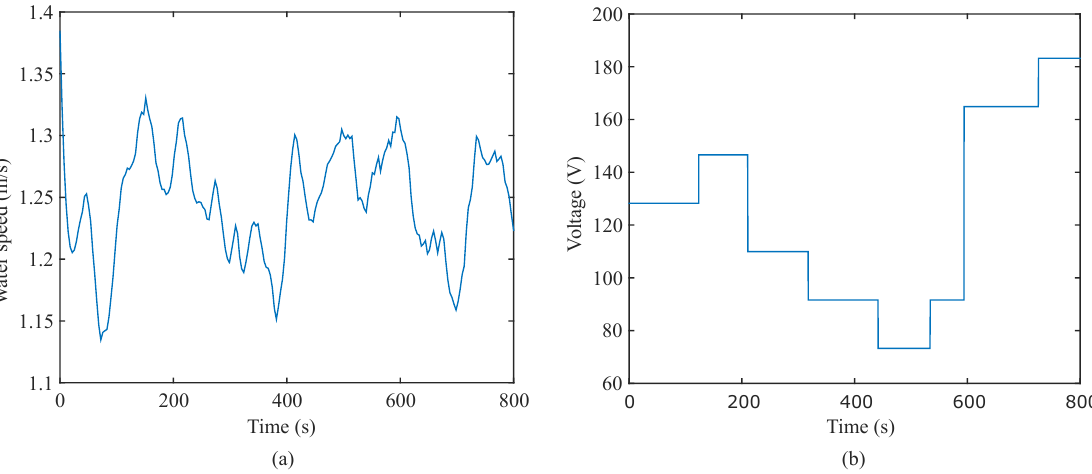
Figure 8. Experimental data that was used as input for the step response simulation: ( a ) Measured water speed in the river; ( b ) Set target DC bus